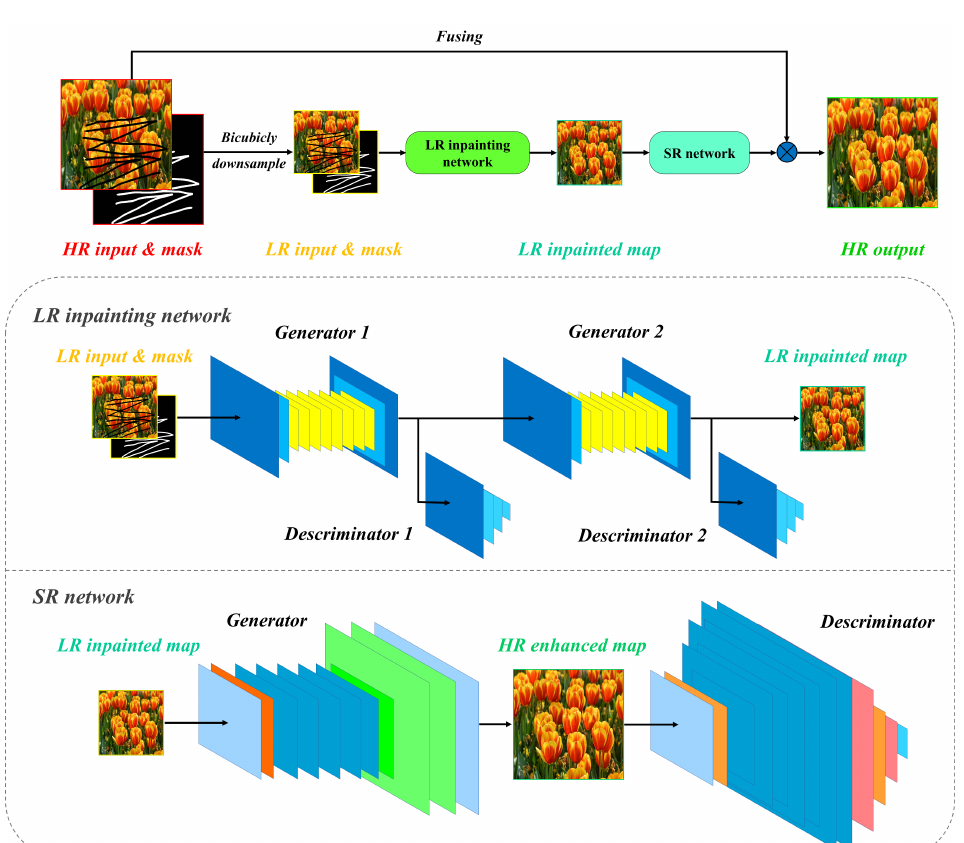
Figure 1. The overall pipeline of our method (SR-Inpaint): ( top ) the pipeline of SR-Inpaint, ( bottom ) the architectures of networks.